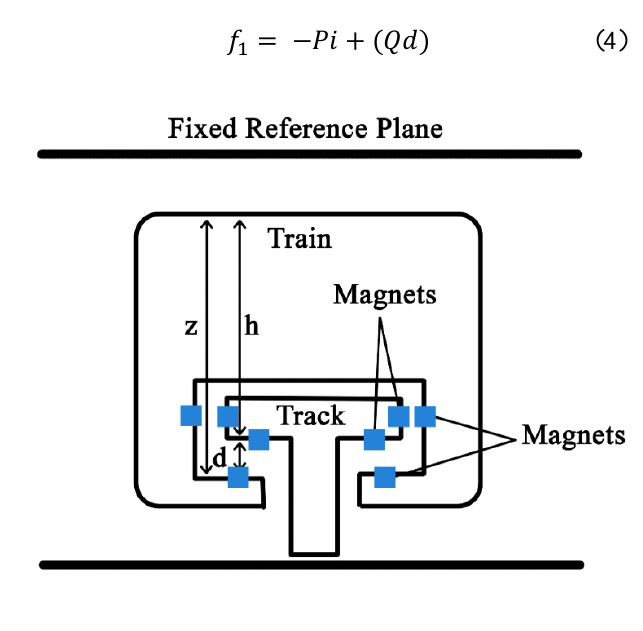
Fig. 2. Cross Section of Maglev Train [12]